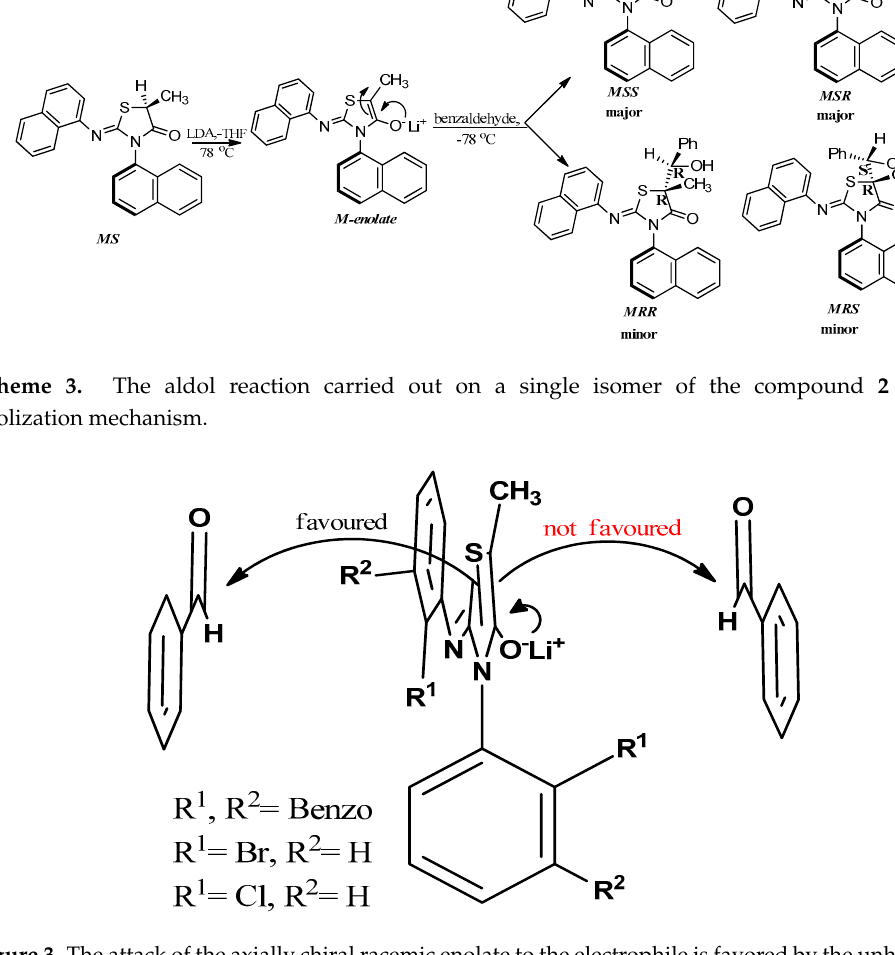
Table 1. The diastereoselectivities a observed before and after recrystallization. Compounds Before Recrystallization b